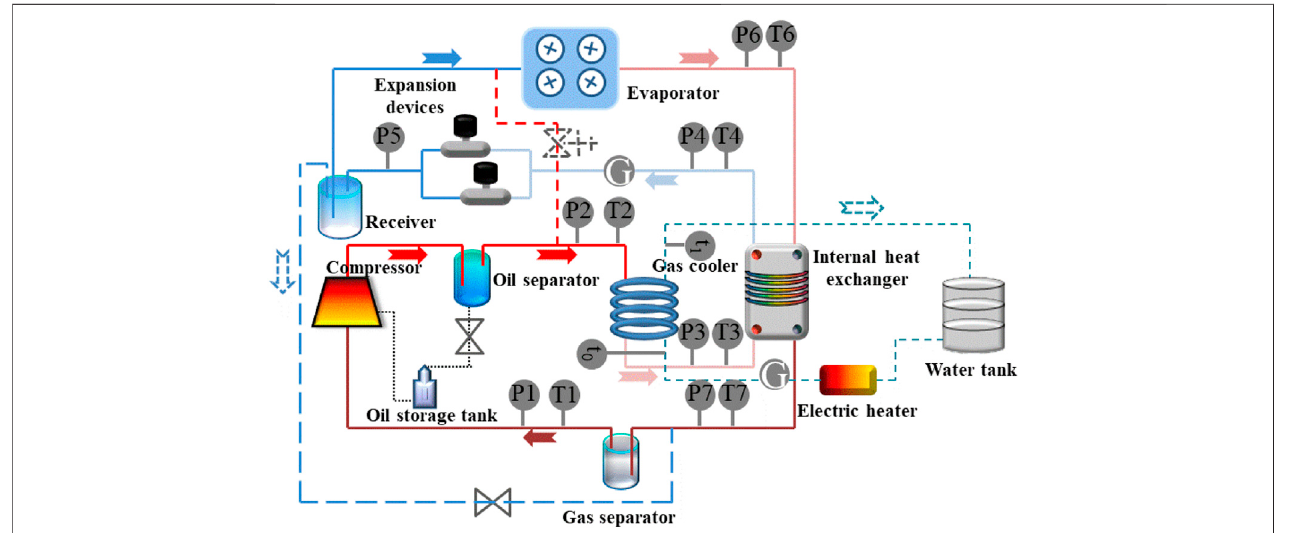
FIGURE 1 | Schematics of a transcritical CO 2 heat pump